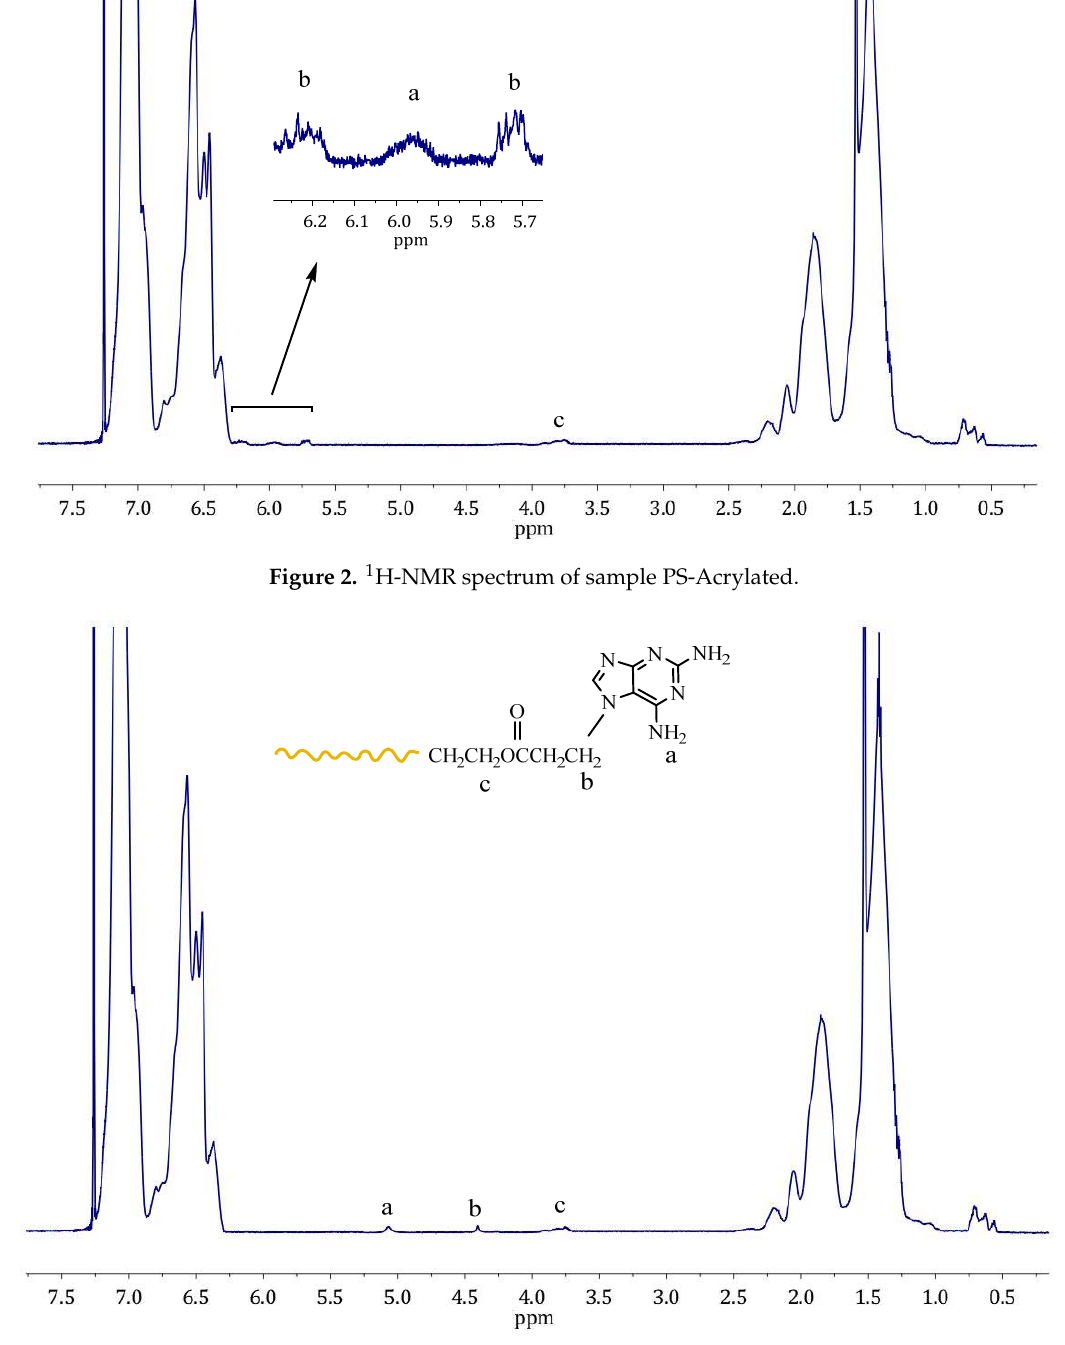
Figure 3. 1 H-NMR spectrum of sample Figure 3. 1 H ‐ NMR spectrum of sample PS ‐ Dap.